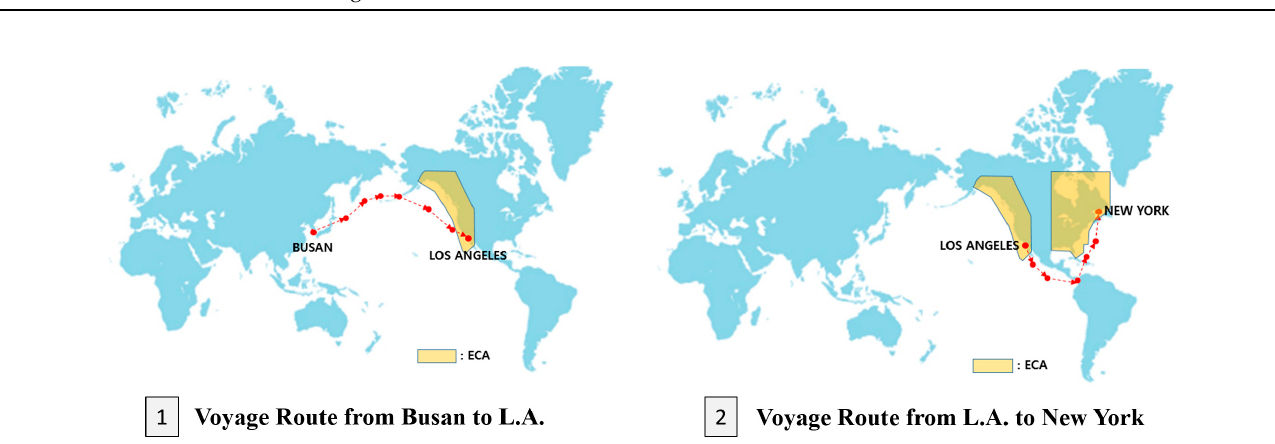
Figure 3. Voyage routes of case ship.